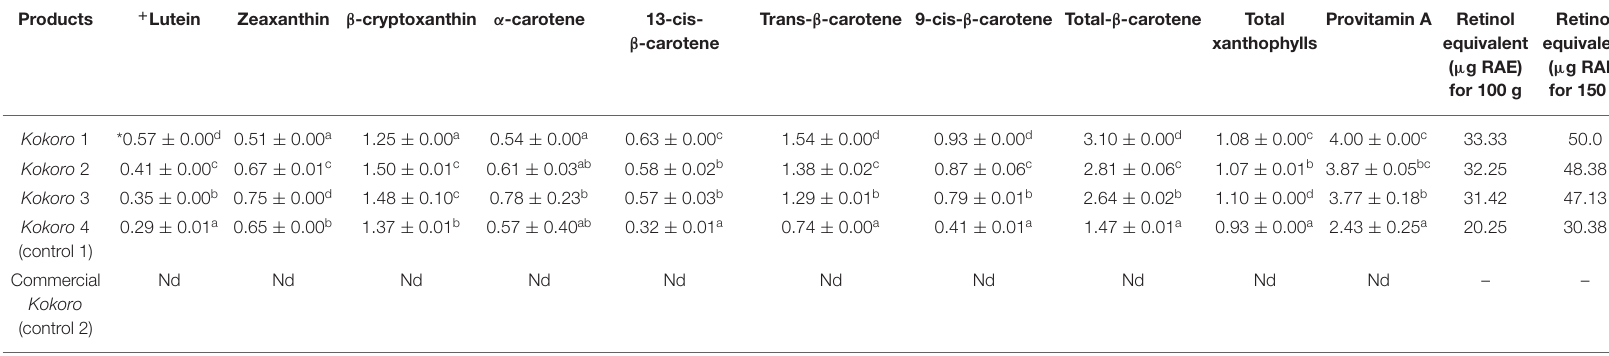
* Values are the mean ± standard deviation of triplicate determination. + Values with the same superscript along the column are not significantly different from one another (p ≥ 0.05). Nd, Not